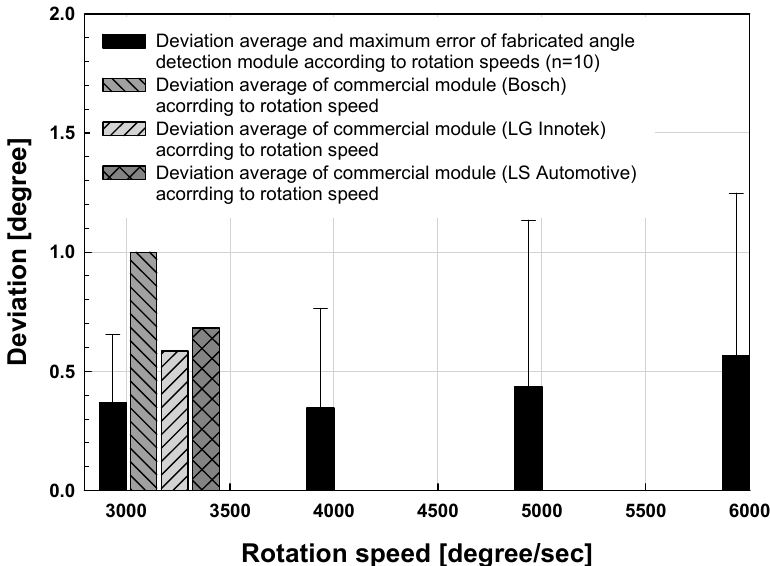
Figure 11. Deviation results of the proposed angle sensor module due to rotation speed.